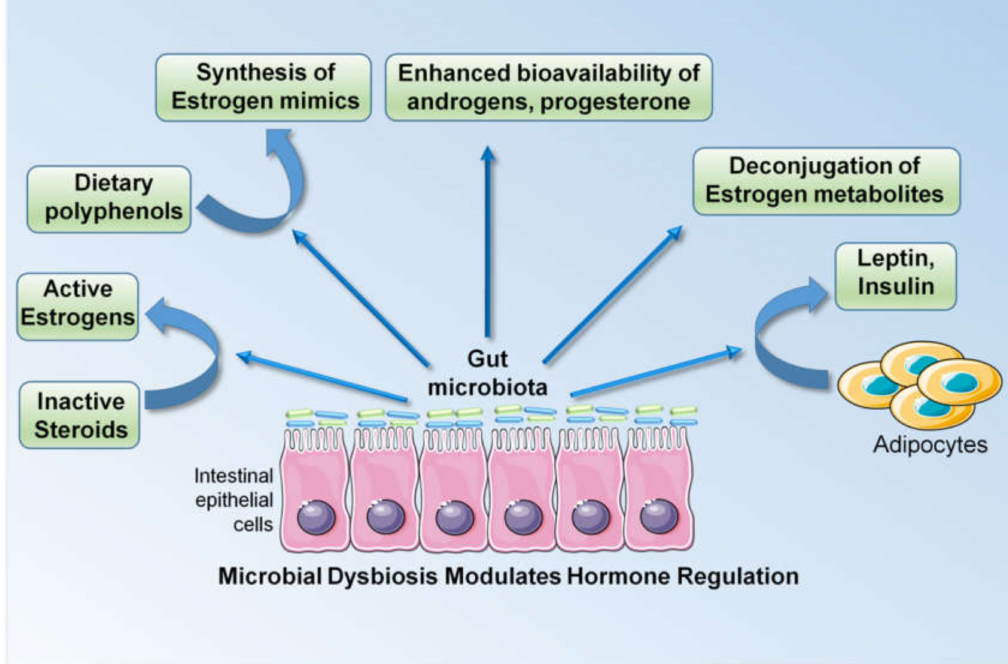
Figure 2. Changes in gut microbiota alter the levels of circulating hormones and cytokines / adipocytokines, which act as effector molecules, mediating the biological effect of